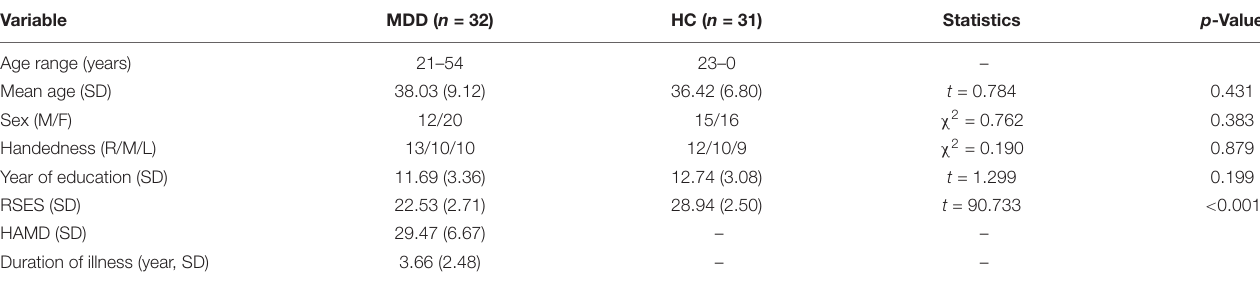
TABLE 1 | Demographic characteristics and clinical information of two